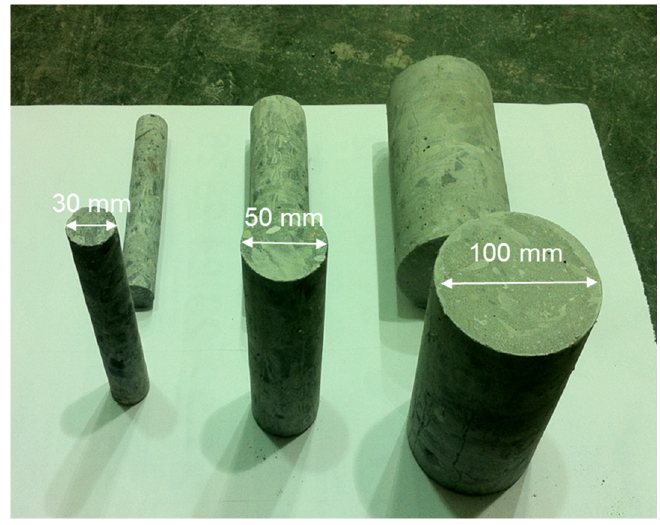
Figure 7. Extracted core specimens for diameter of 30, 50, 100 mm.